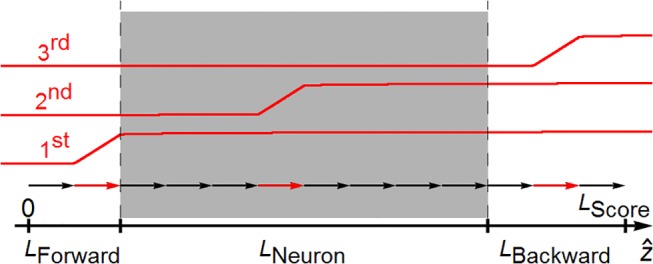
Longitudinal component of dose contribution to the inner, Cyl
Neuron cylinder section.Along the z-axis, the gray shaded rectangle represents the length of the Cyl
Neuron and each sequential arrow (black and red) is made up of random histories of length L
Track (20 μm) to establish a particle beam in Cyl
Score. Axis length of Cyl
Score, L
Score is the sum of L
Forward, L
Neuron and L
Backward. Three red arrows are chosen to show contribution of these tracks to the ED in Cyl
Neuron. Corresponding three red curves are the longitudinal component of translated dose distribution of normalized deposited energies. The longitudinal contribution of any history (red curve) to the Cyl
Neuron (shaded area) is the absolute value of the differences of these curves at entrance and exit points to the Cyl
Neuron (dashed lines). The contributions of all the tracks (13 in this figure) are added and the sum is divided by the number of tracks bounded by the length L
Neuron (8 in the figure). The tracks along both L
Forward and L
Backward act as the longitudinal component of build-up materials to reach electronic equilibrium in L
Neuron.